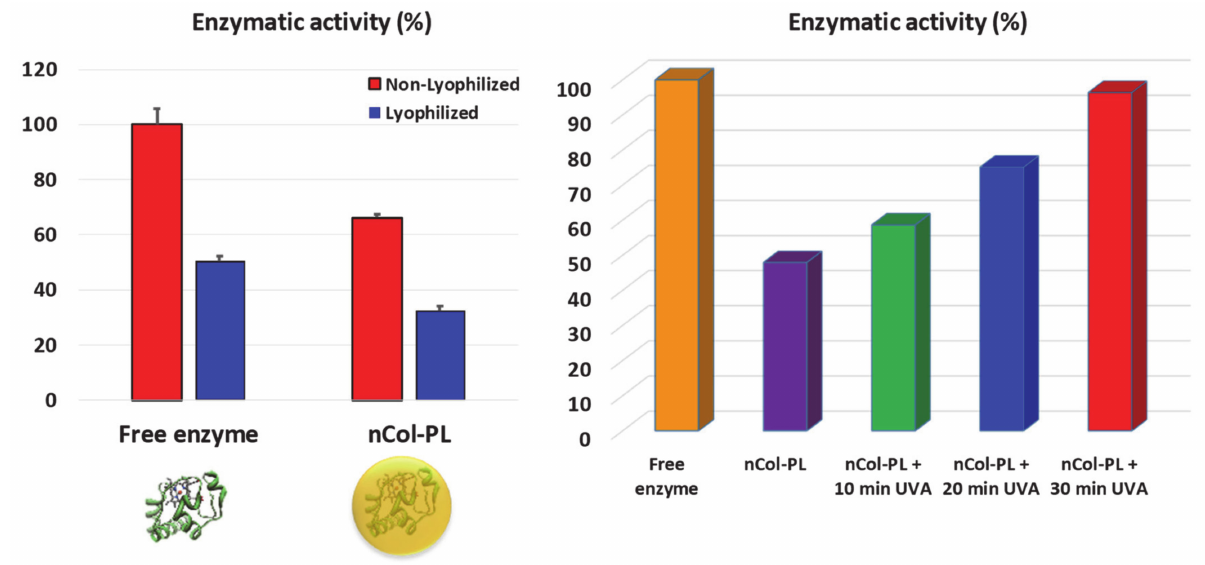
Figure 5. Left: Collagenase enzymatic activity (%) for free collagenase and nCol-PL nanocapsules measured before (red bars) and after (blue bars) lyophilization. Right: Collagenase activity (%) of free collagenase (orange bar), non-irradiated nCol-PL (purple bar) and irradiated nCol-PL with 10 min (green bar), 20 min (blue bar) or 30 min (red bar) of UVA light. Bars represent mean ± standard error of the mean ( n = 3). p < 0.05 vs. free enzyme and nCol-PL. (Student’s two-tailed t